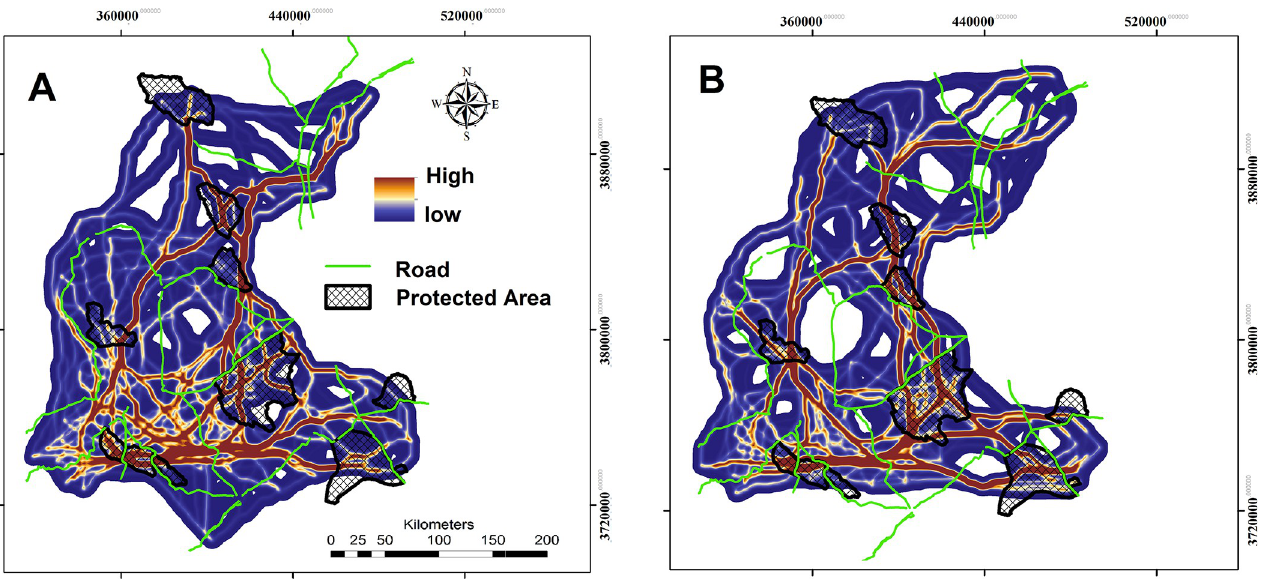
Fig 5. UNICOR corridor pathways for the golden jackal (A) and the grey wolf (B) in Central Iran. Republished from [http://www.frw.ir] under a CC BY license, with permission from [Forest, Range, Watershed Management Organization of Markazi province (IFRWO)], original copyright [2021]. Republished from [https://markazi.doe.ir/] under a CC BY license, with permission from [Markazi Province Office of Department of Environment (DOE)], original copyright [2021].